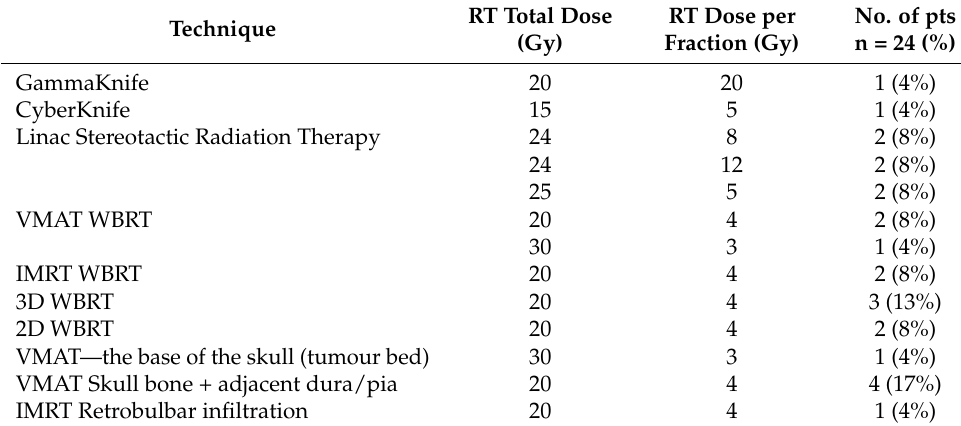
Table 2. Radiation therapy